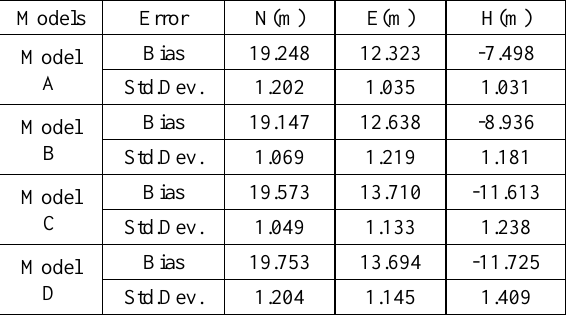
Table 4. The a-priori sensor accuracy of the ZY-3 triplet stereo images